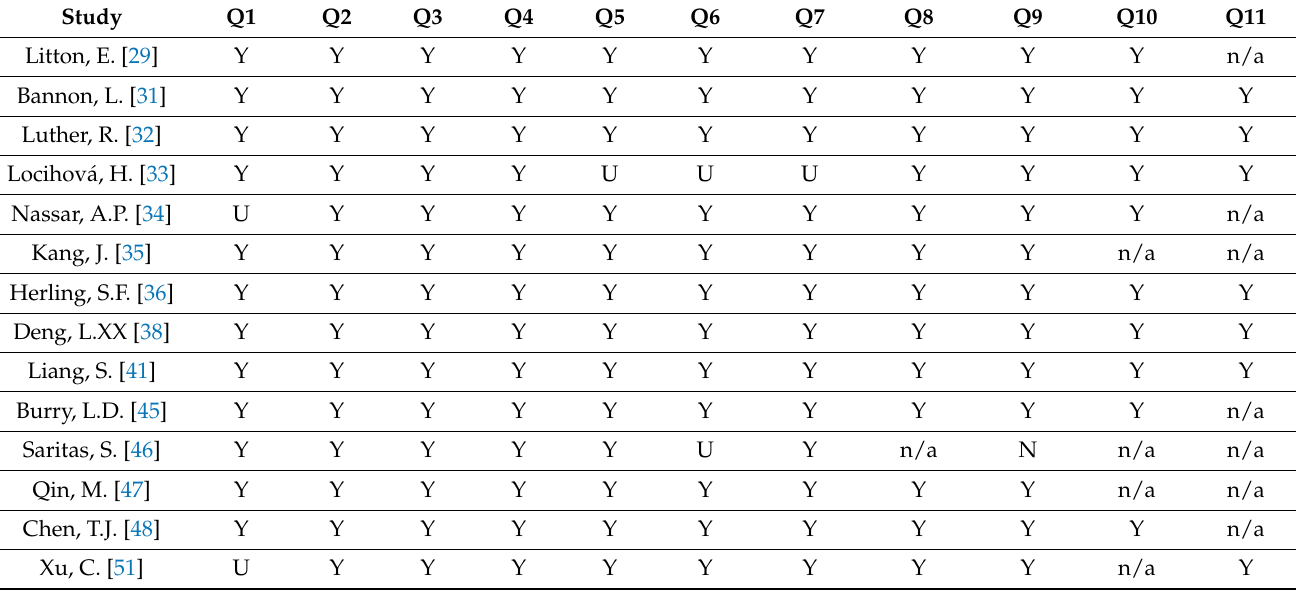
Table 3. Critical appraisal results for included studies using the